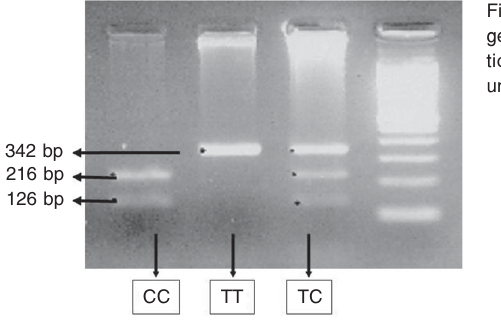
Figure 1. Genotypes of 5-HT2A gene polymorphism. The diges- tion products were visualized under UV light.